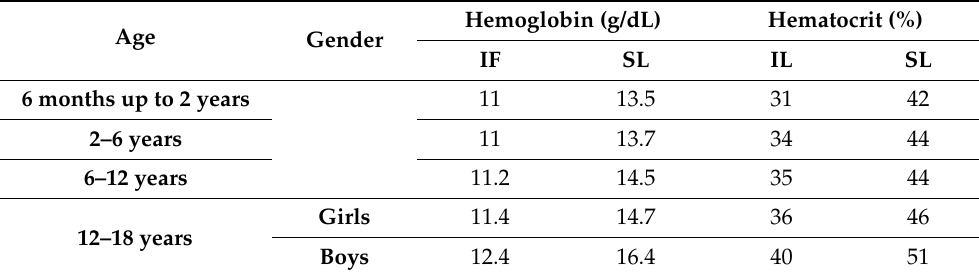
Table 2. Normal hemoglobin and hematocrit values for age groups [11].